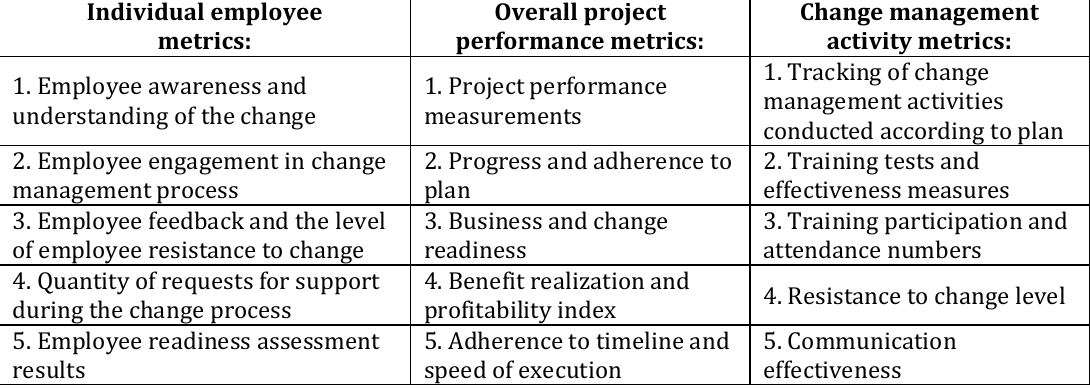
Table 1: Metrics used to measure the change management process